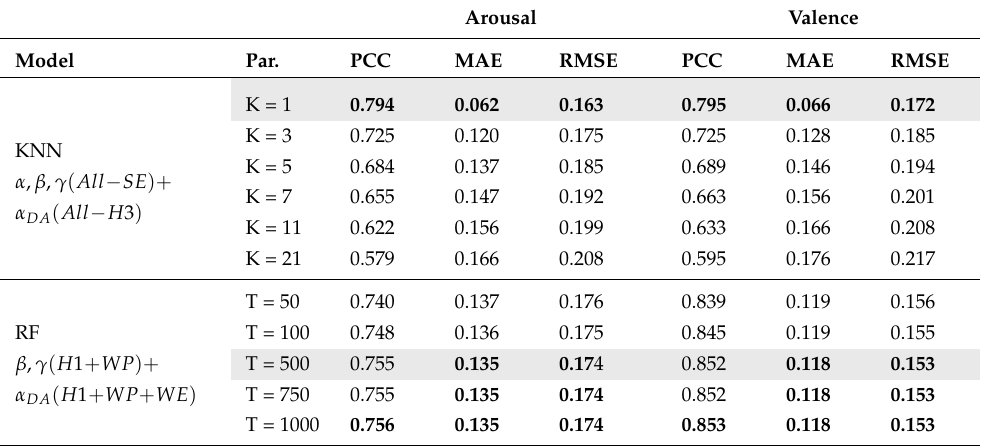
Table 6. Results for the optimization of the KNN and RF models, for different values of K, Manhattan distance and number of trees (T). Values in bold represent the best results for each model. Grey rows represent the selected parameters. Arousal Valence Model